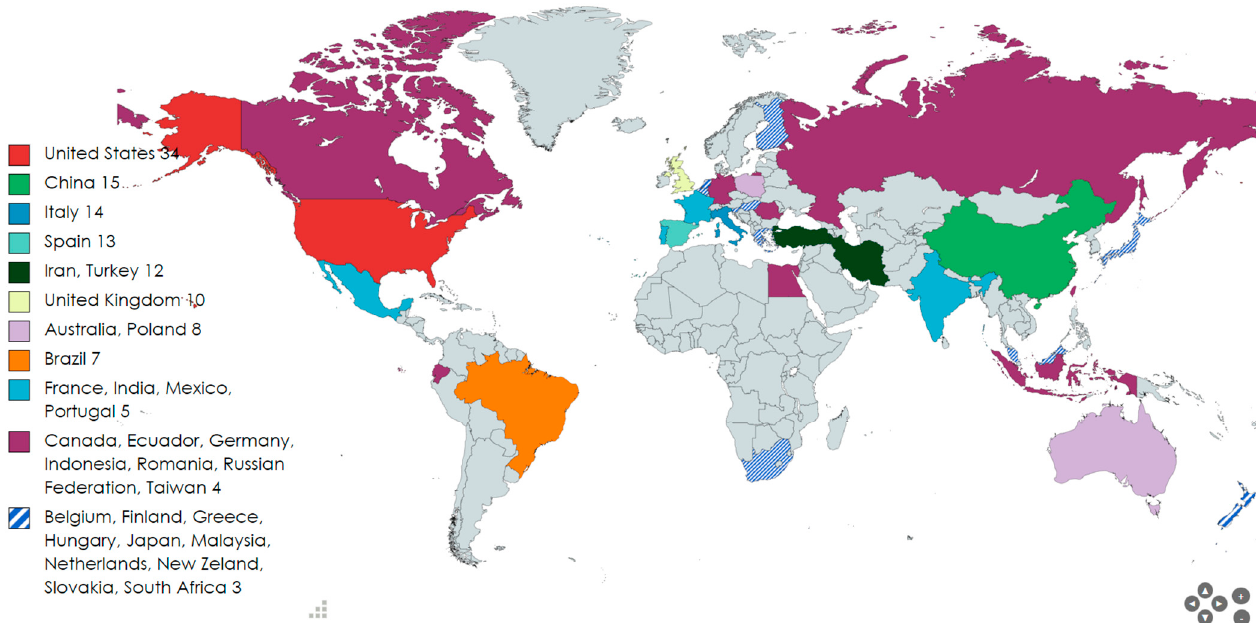
Figure 2. Countries rank the productivity of tourism and planning in natural places.